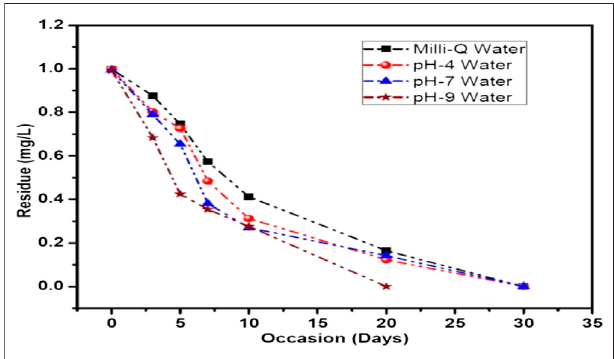
FIGURE 13 | Graph representing the dissipation curve of photolytic decontamination of fl umioxazin in water under direct sunlight.